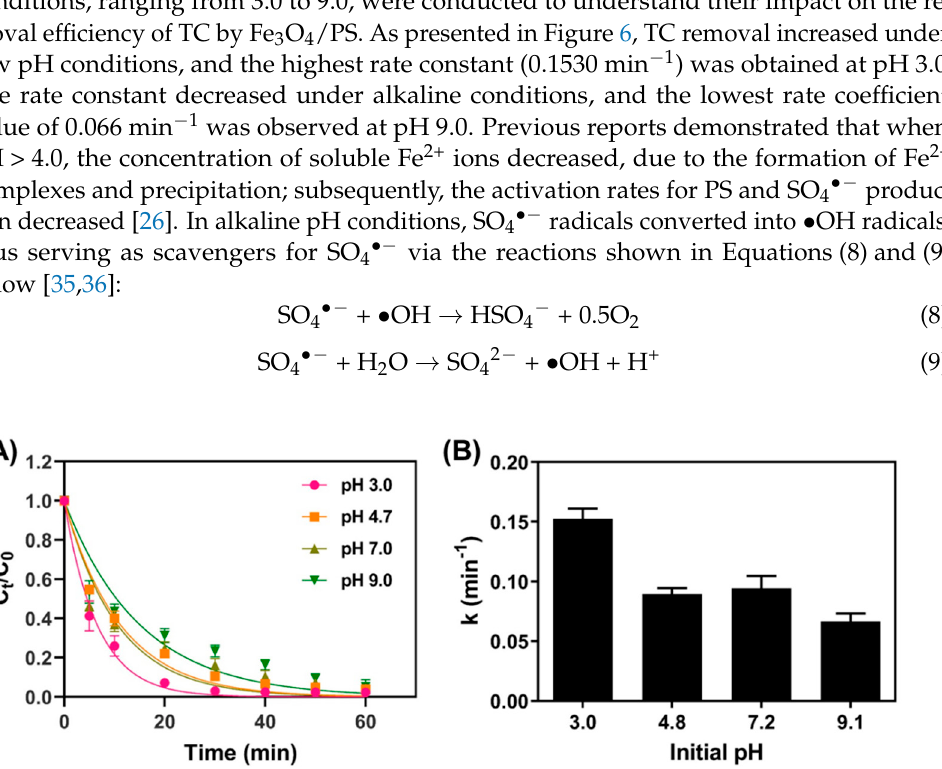
Figure 6. ( A ) TC removal efficiency for samples with different initial pH conditions ([Fe 3 O 4 ] = 1.0 g/L; [PS] =1.0 mM; [TC] = 41.6 µ M), and ( B ) reaction rate coefficient versus pH.